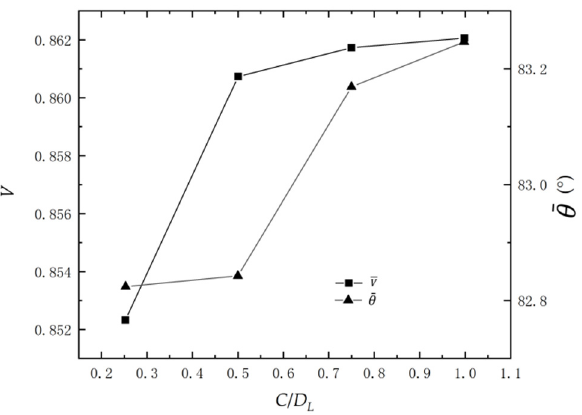
Figure 21. Velocity uniformity and weighted average angle curve with different floor distance.